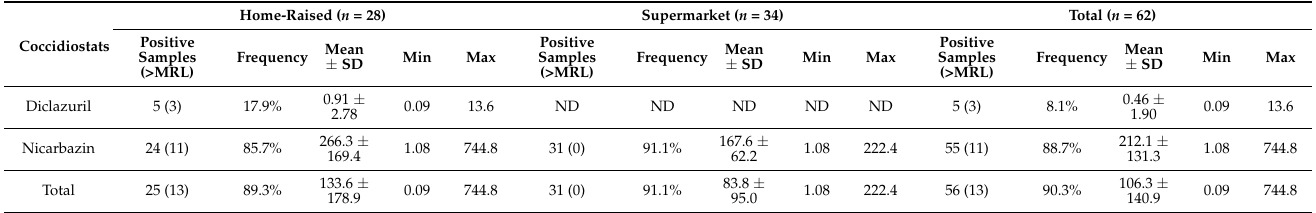
Figure 1 . Box and whiskers for the concentrations of the detected coccidiostats diclazuril (blue) and nicarbazin (green) ( a ) and in home-raised (green) and supermarket samples (blue) ( b ). Table 3. Frequency (%), mean levels ( µ g kg − 1 ), and range of concentrations ( µ g kg − 1 ) of coccidiostats in samples obtained from different providers.